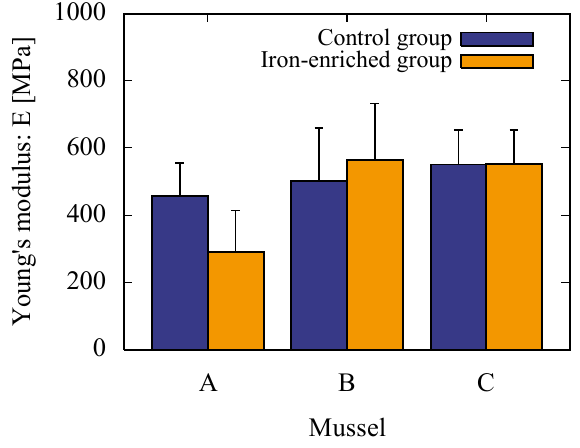
Fig. 13 Young’s modulus of byssal threads (error bars indicate 95% mean confidence intervals).